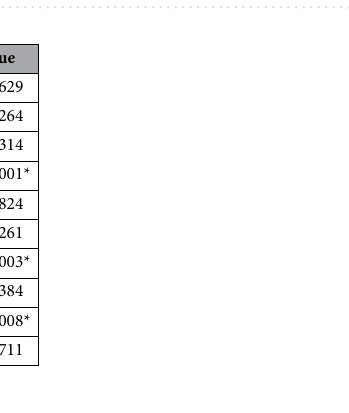
Figure 3. Time to discontinuation of TKI ( a ), progression-free survival ( b ) and overall survival ( c ) curves of patients with miliary (blue line) and non-miliary (green line) lung metastasis.